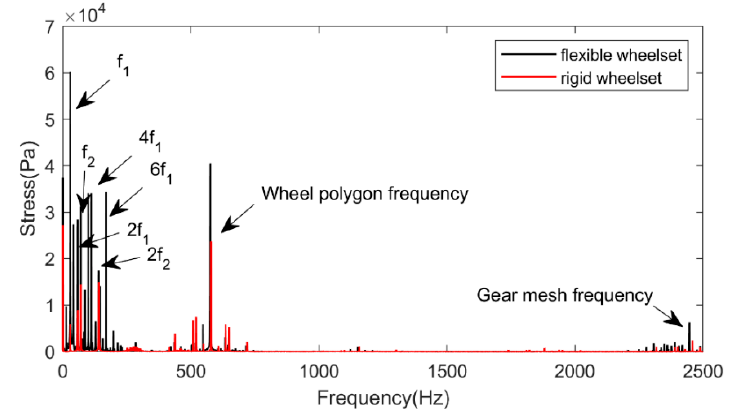
Figure 18. Spectra of the stress of the gearbox housing considering gear transmission.